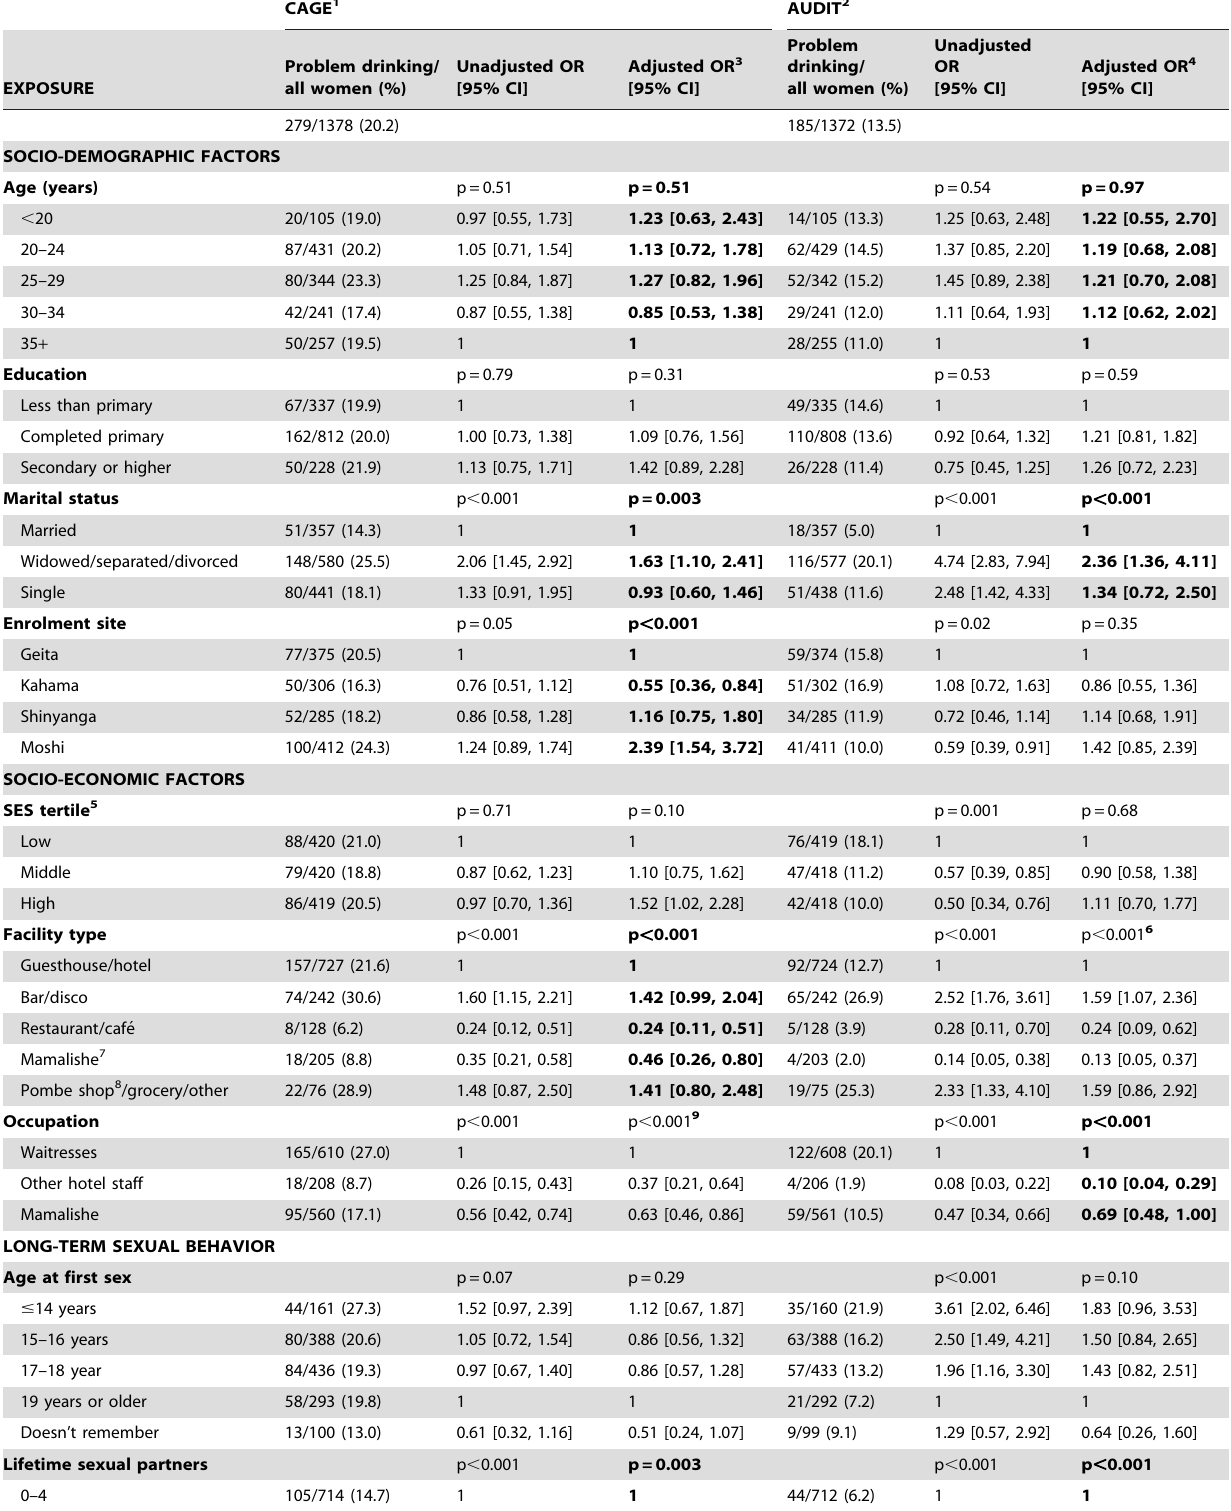
Table 3. Associations between problem drinking (based on CAGE and AUDIT) and long-term sexual behavior, socio-demographic and economic factors at the time of enrollment in a cohort of women working in food and recreational facilities in northern